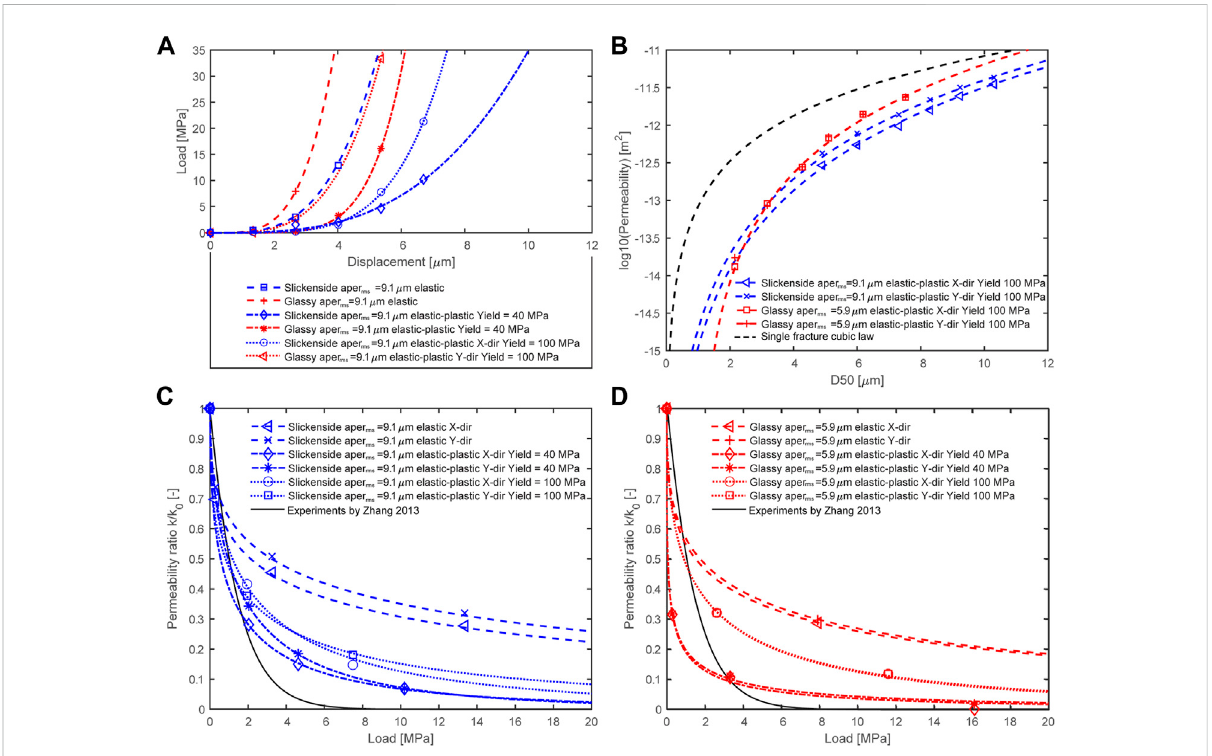
FIGURE 8 (A) Relationshipbetweenverticalloadandverticaldisplacementduringthevirtualcompressionexperimentinthecaseofaslickensideorglassy fracturesurface. (B) PermeabilityinrelationtothemeanapertureD50relatedtofractureclosurebycompressionandforelastic-plasticdeformation. (C) Ratio between reduced and initial permeability as afunction ofapplied normalload for slickensides under elastic and elastic-plasticdeformation. (D) Same as (C) but for glassy